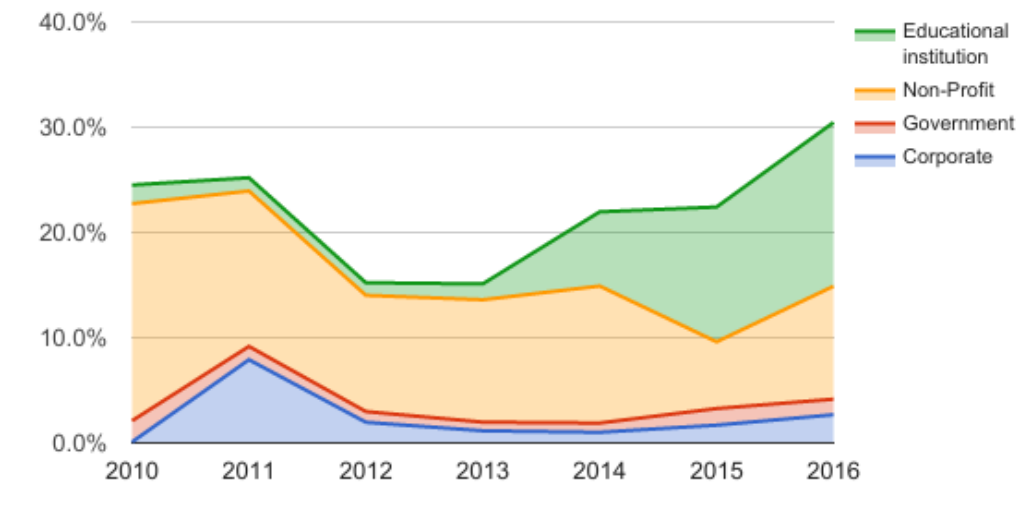
Figure 5. Organizational account tweets by year and